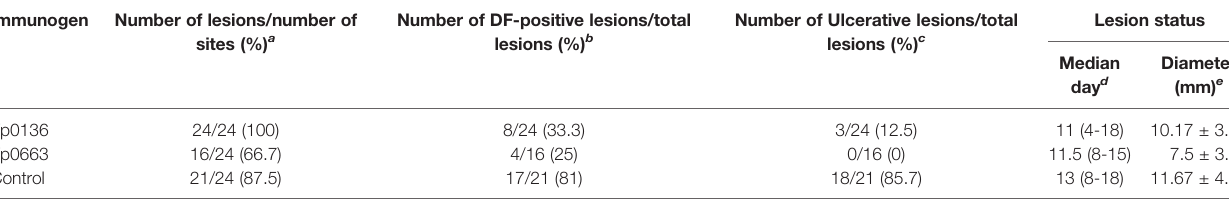
TABLE 2 | Lesion data for control and immunized